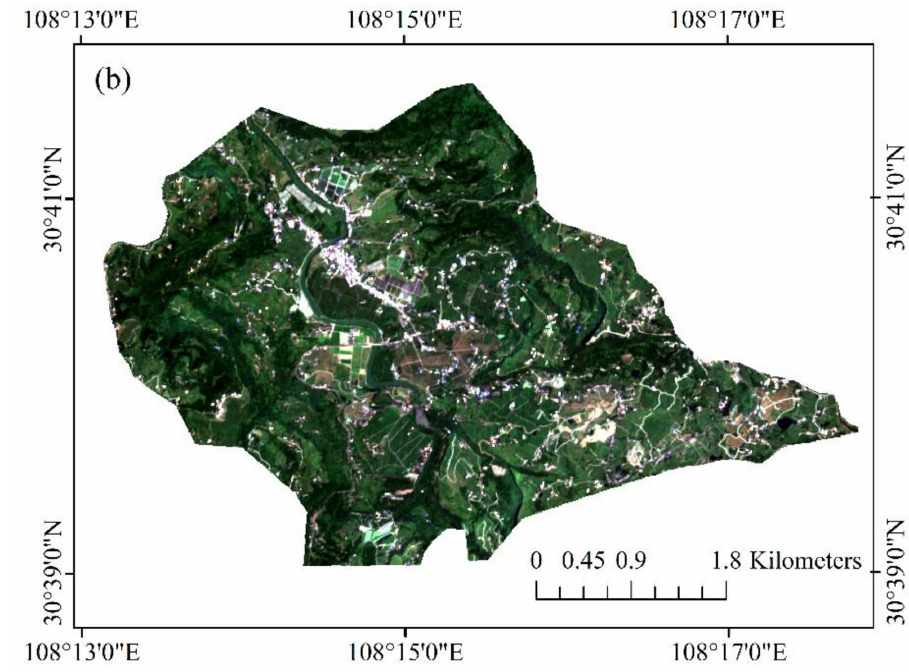
Figure 1. ( a ) Location of study area and distribution of soil sample points and ( b ) RGB (red: 665 nm; green: 560 nm; blue: 490 nm) images acquired by optical satellite imagery (Sentinel-2)